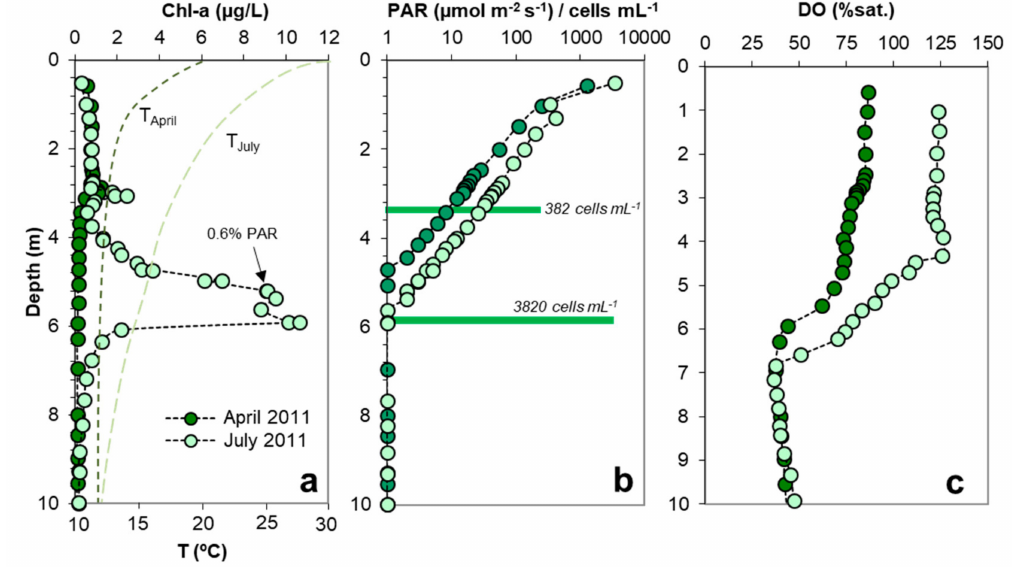
Figure 5. Depth profiles of chlorophyll-a concentration ( a ), PAR ( b ) and DO concentration ( c ) across the photic zone (upper 10 m) of San Telmo APL in two di ff erent seasons. The horizontal green bars in (b) indicate the total number of cell counts of phytoplanktonic phototrophs at depths of 3.5 and 6